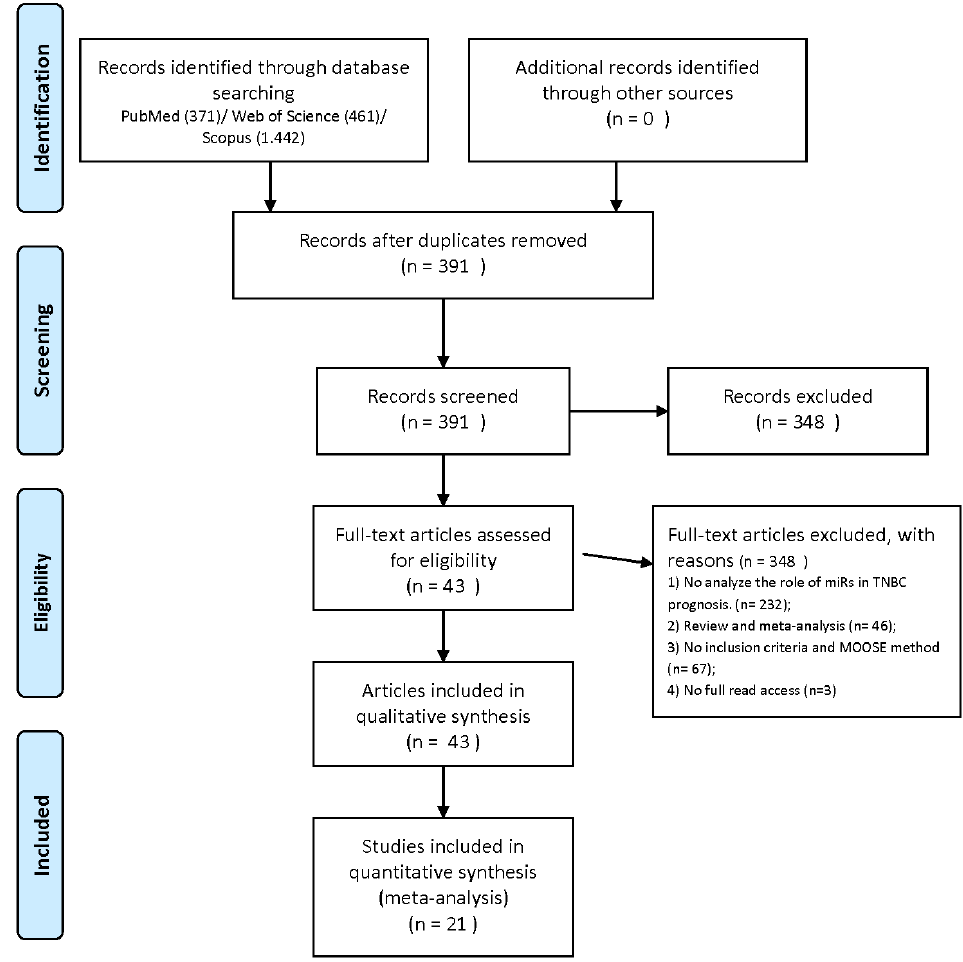
Figure 1. Flowchart of the study selection process.